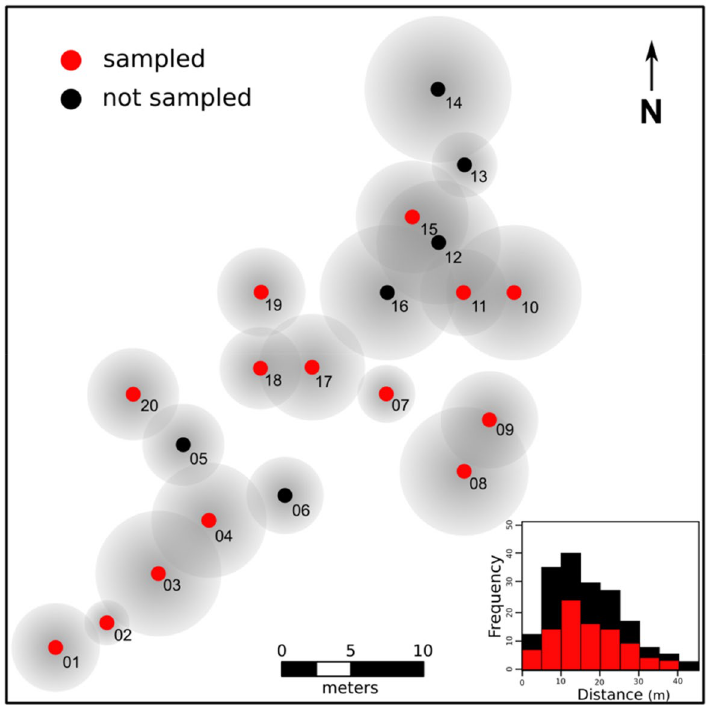
Figure 1. Spatial distribution and histogram of the frequency of distance classes of pairwise trees within the studied landscape. Numbers refer to IDs of trees hosting the Tillandsia recurvata populations analyzed. Gray circles around each dot are representations of the crown area of each tree. Red dots and bars represent, respectively, the location and frequency of distances among